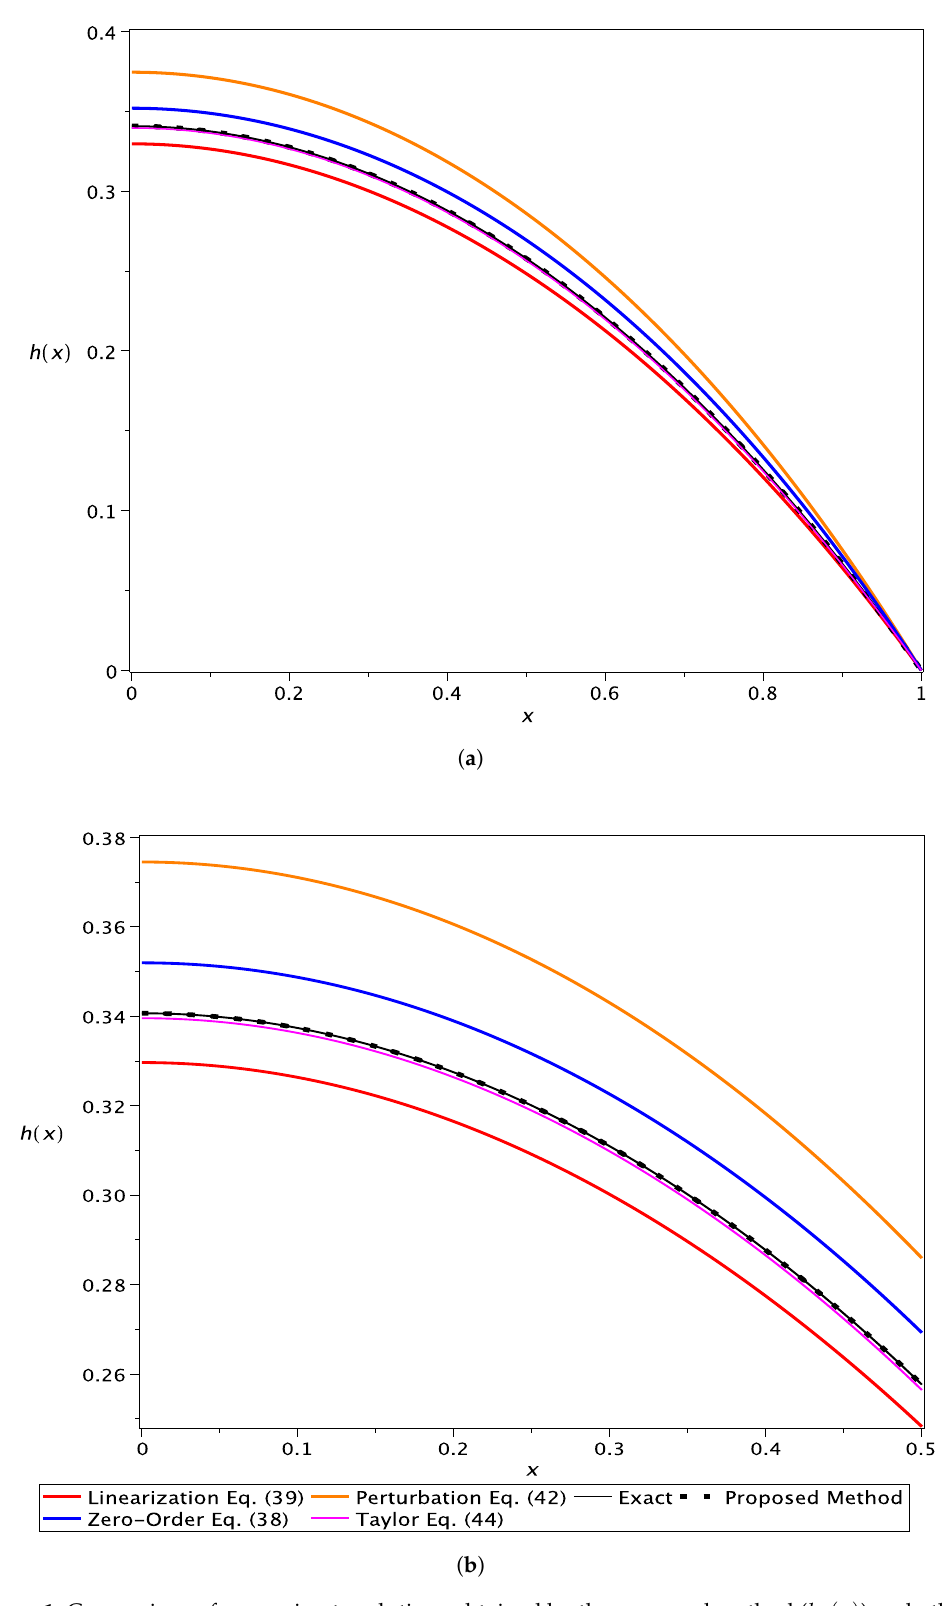
Figure 1. Comparison of approximate solutions obtained by the proposed method ( h 5 ( x ) ) and other methods for Equation (2) with a = 1 and b = 1. ( a ) Entire domain ( 0 ≤ x ≤ 1 ) . ( b ) Closeup ( 0 ≤ x ≤ 0.5 )